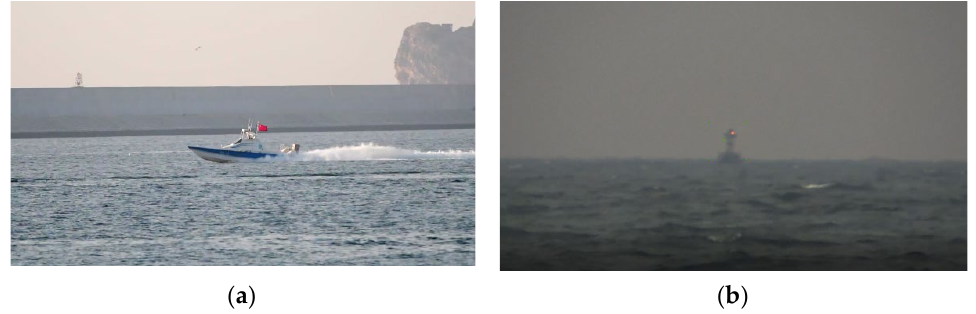
Figure 1. “Tianxing-1” unmanned surface vehicle: ( a ) The image of “Tianxing-1” during its mission; ( b )The optical image of the “Tianxing-1” unmanned surface vehicle performing maritime missions in a foggy environment.